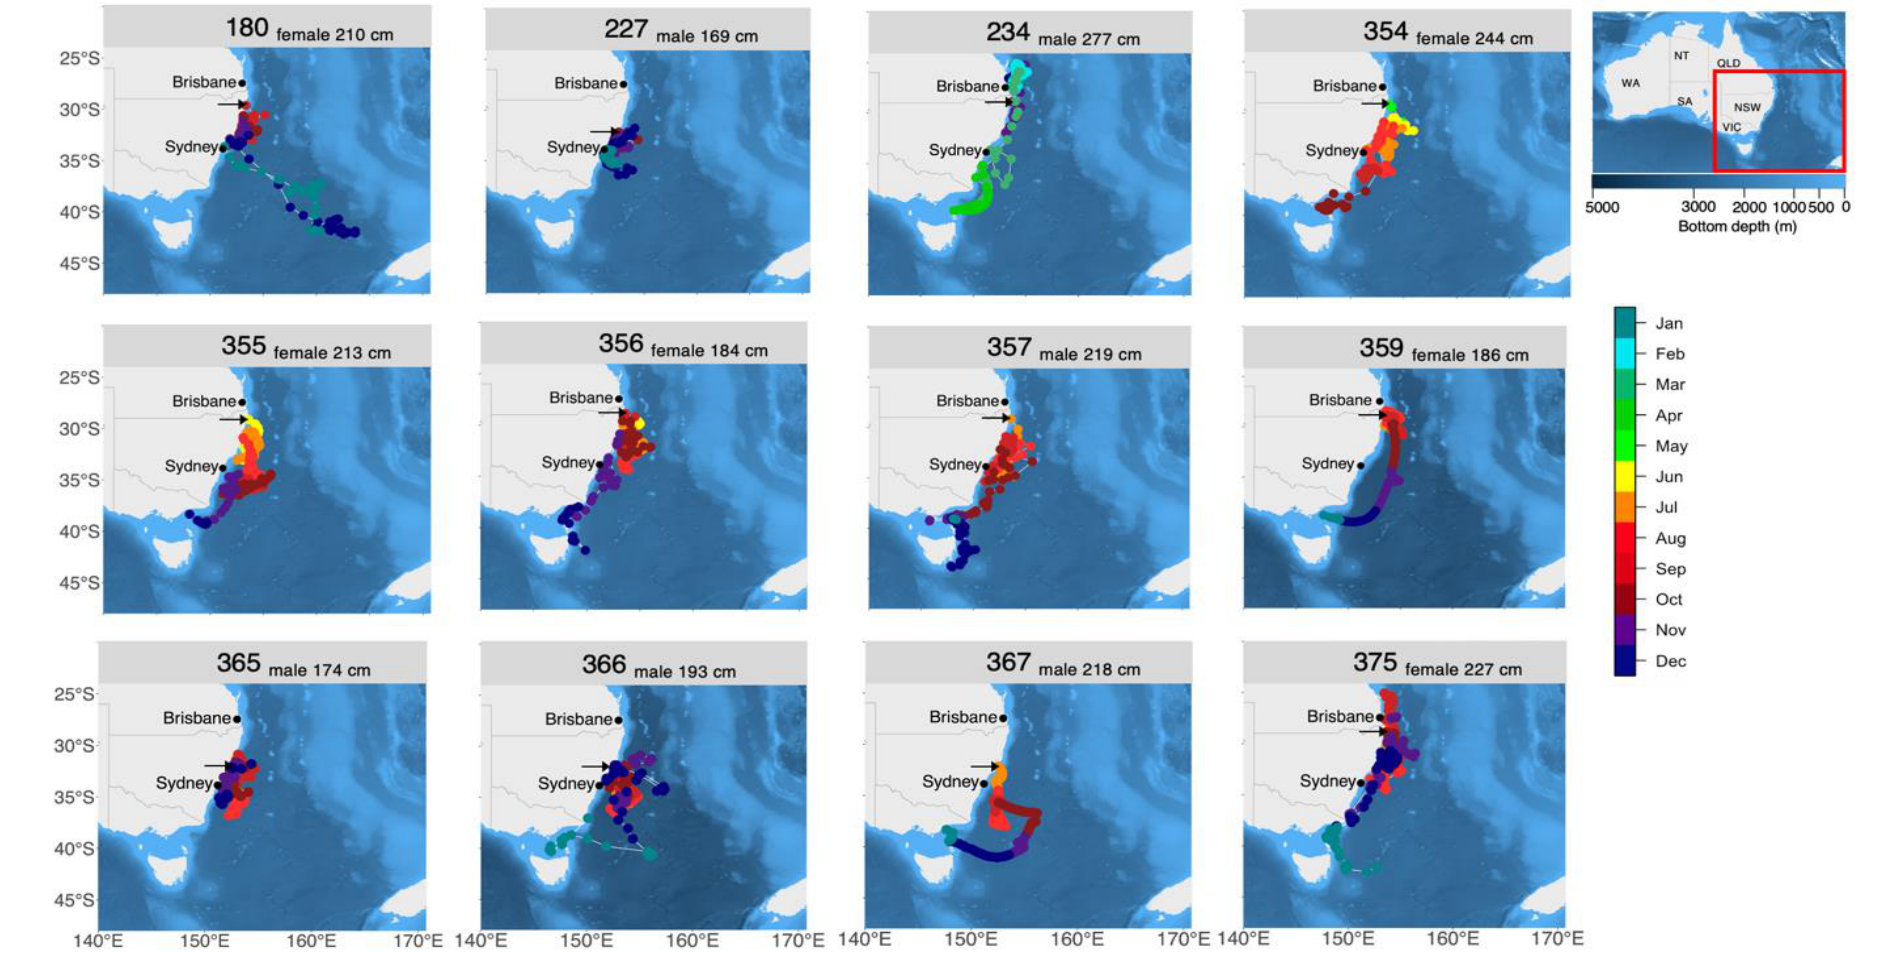
Figure 1. Spatial scale of individual movements. Interpolated telemetry tracks of 12 juvenile white sharks tagged off eastern Australia from a combination of satellite-linked radio, pop-up satellite archival, acoustic and recapture records collected between 12 September 2017 and 1 March 2020. Positions are colour-coded by month. Arrows indicate tagging locations. Red square indicates the study area. ID numbers, sex and fork length of tagged sharks are indicated above each map. All maps were generated using the marmap package in R [37].